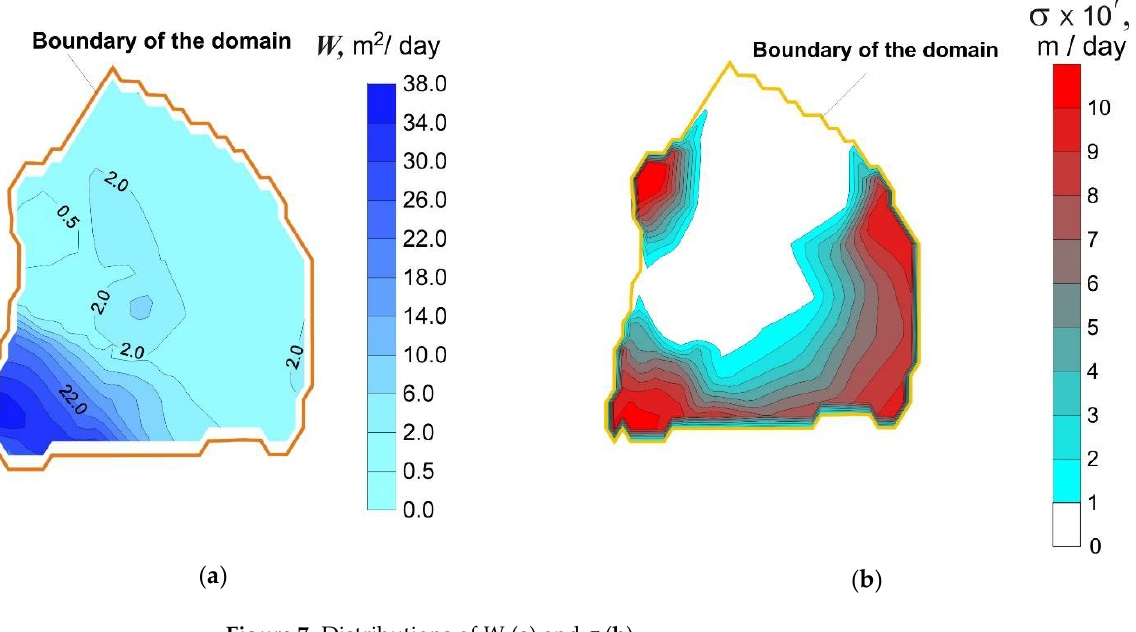
H is presented in Table 1. 1